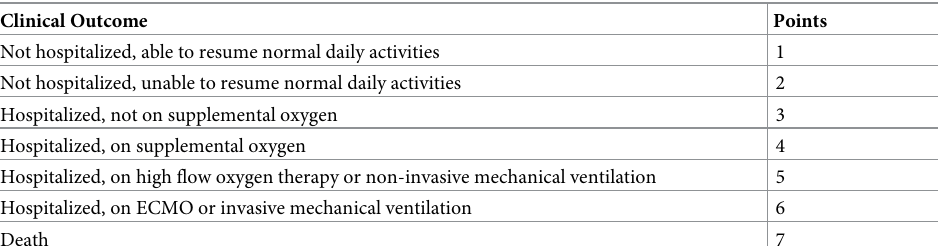
Table 1. Primary outcome 7-point ordinal